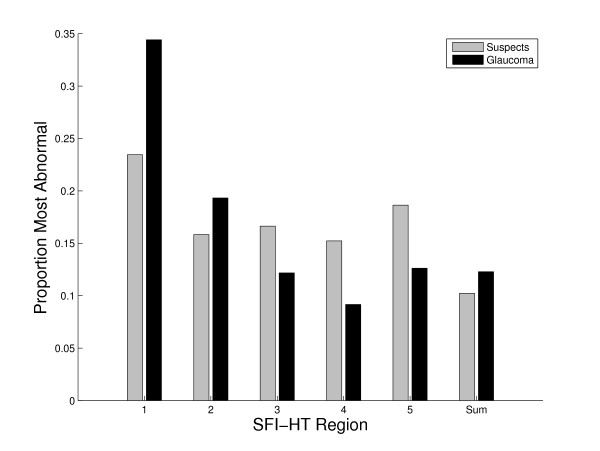
Distribution of the most abnormal SFI-HT regions. Distribution of the statistically most abnormal difference between corresponding superior and inferior SFI-HT regions for 499 suspect and 895 glaucoma eyes. The SFI-HT region numbers correspond to the regions in Figure 3 and Sum refers to the sum of all region scores (to account for diffuse loss).